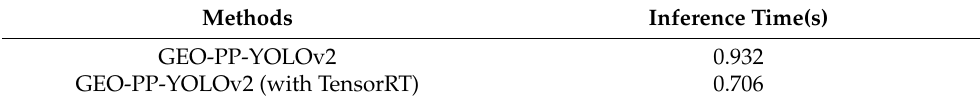
Table 6. Average Inference Time on the NVIDIA Jetson Nano